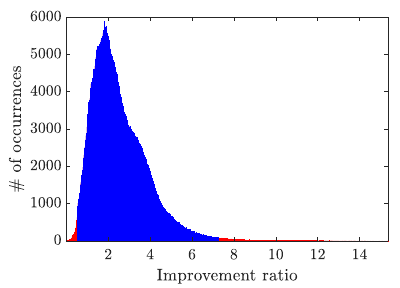
Figure 5. Histogram of improvement ratio for all acquired points. 99 % of the values are represented in blue.